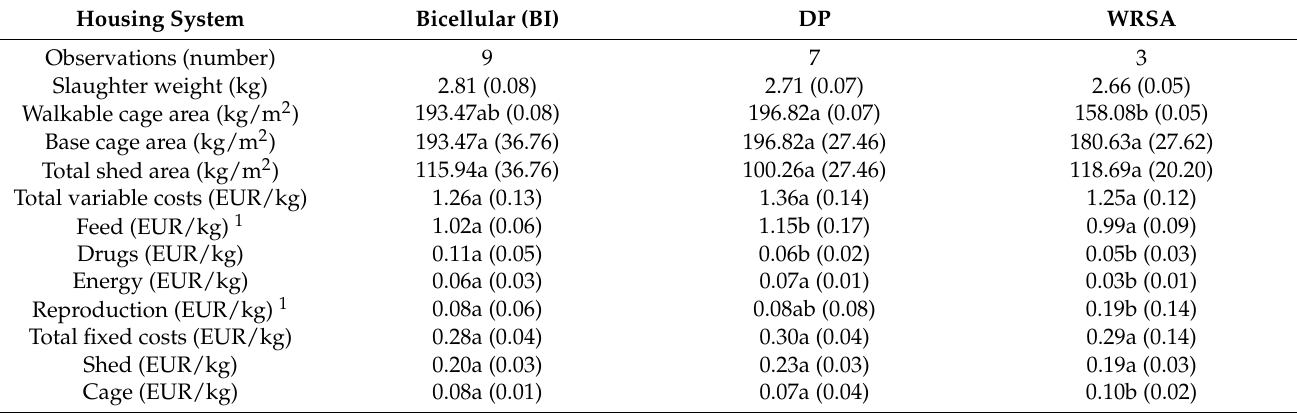
Table 3. Estimations of the productivity and economic indices in the surveyed farms using different housing systems (SD in